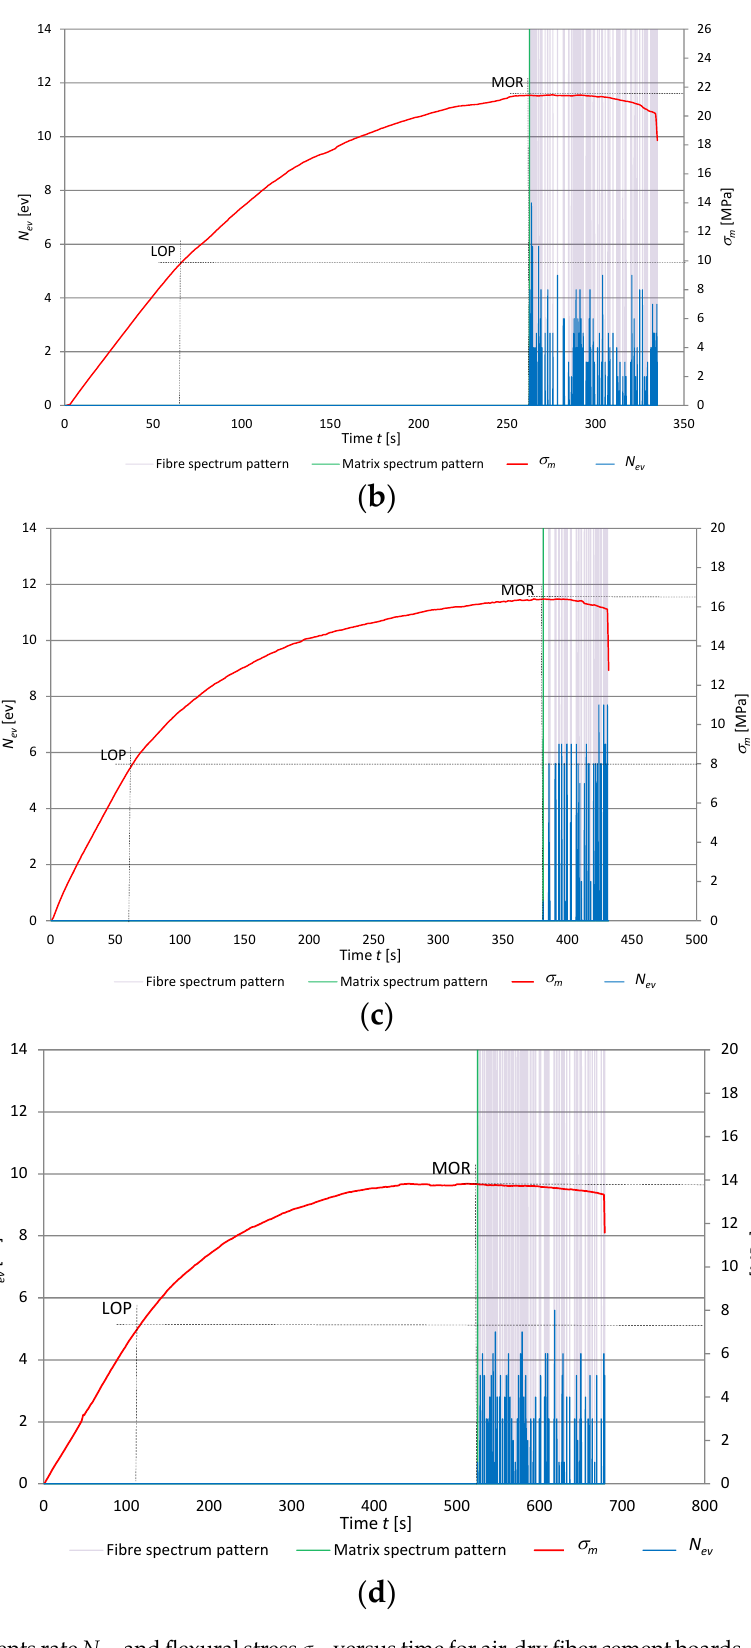
Figure 8. Events rate N ev and flexural stress σ m versus time for air-dry fiber cement boards, with marked identified reference spectral patterns: ( a ) series A, ( b ) series B, ( c ) series C, ( d ) series D.